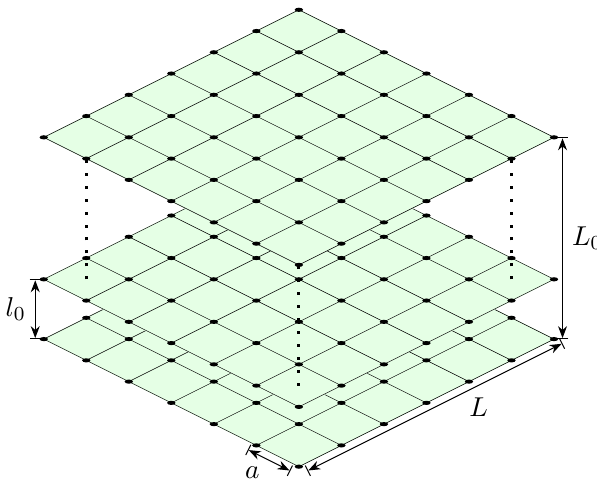
Figure 3. An illustration of a system described in section 3.1 with d = 3, (cid:18) = 1. The two dimensional networks are aligned along the one dimensional vertical line. The dots are the sites of the lattice on which the Hamiltonian acts, and the ellipses denote the intermediate layers that are not drawn in the